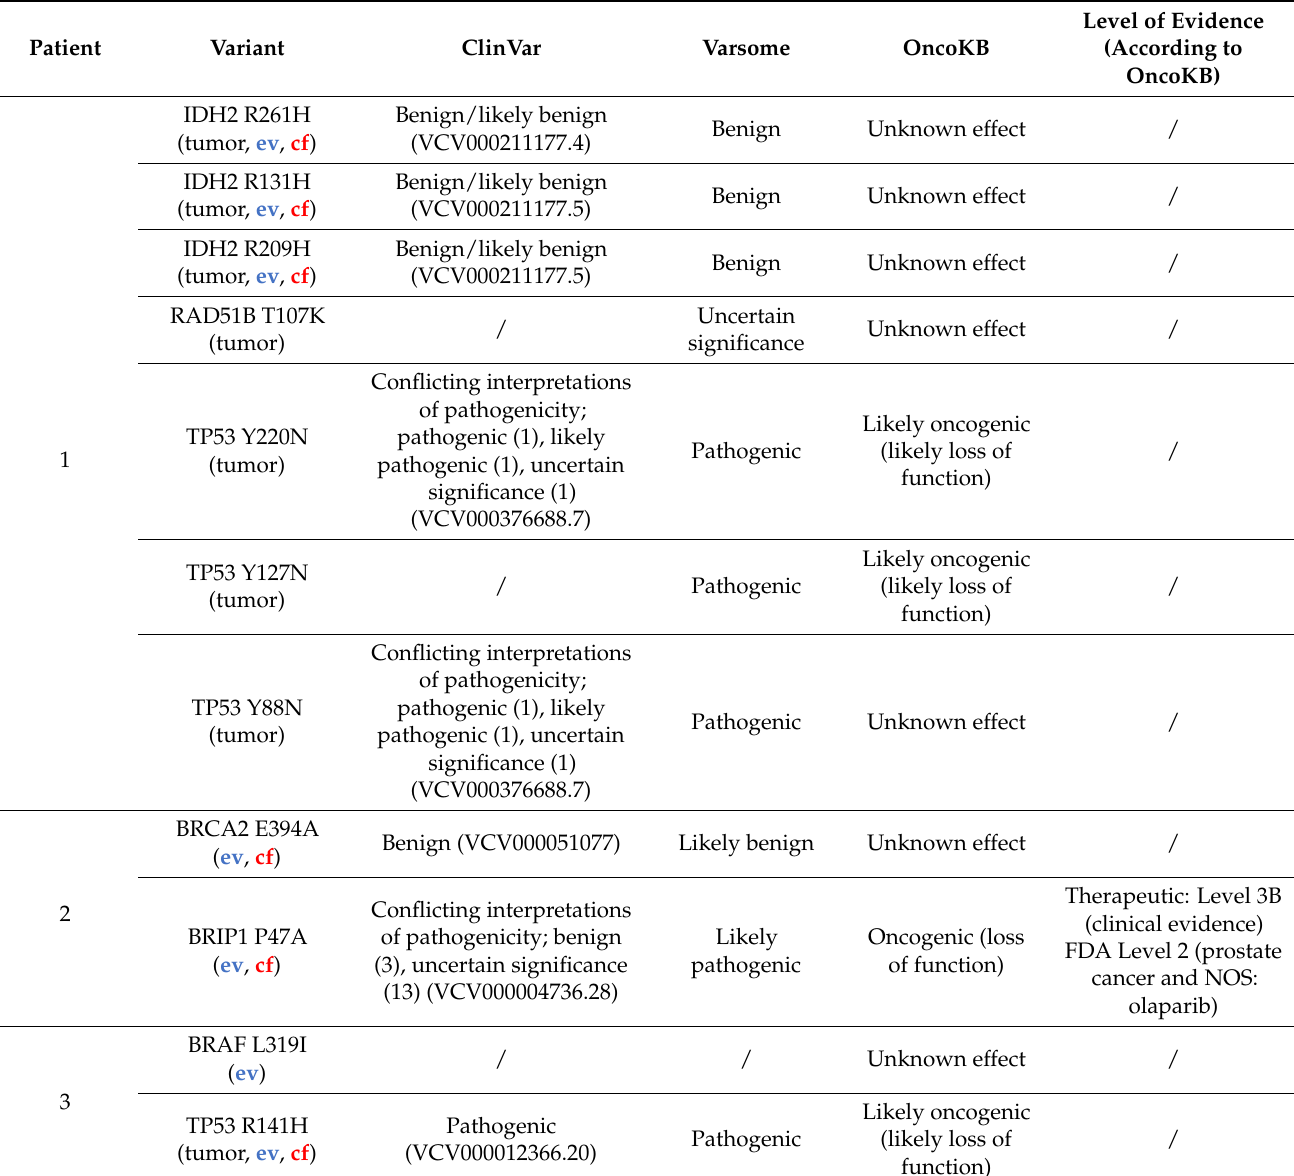
Table 4. Analysis of actionable variants tier 1 + 2 detected in filtered SNVs (AF ≤ 1%; impact: moderate/high) of tumor-, ev- and cfDNA utilizing different